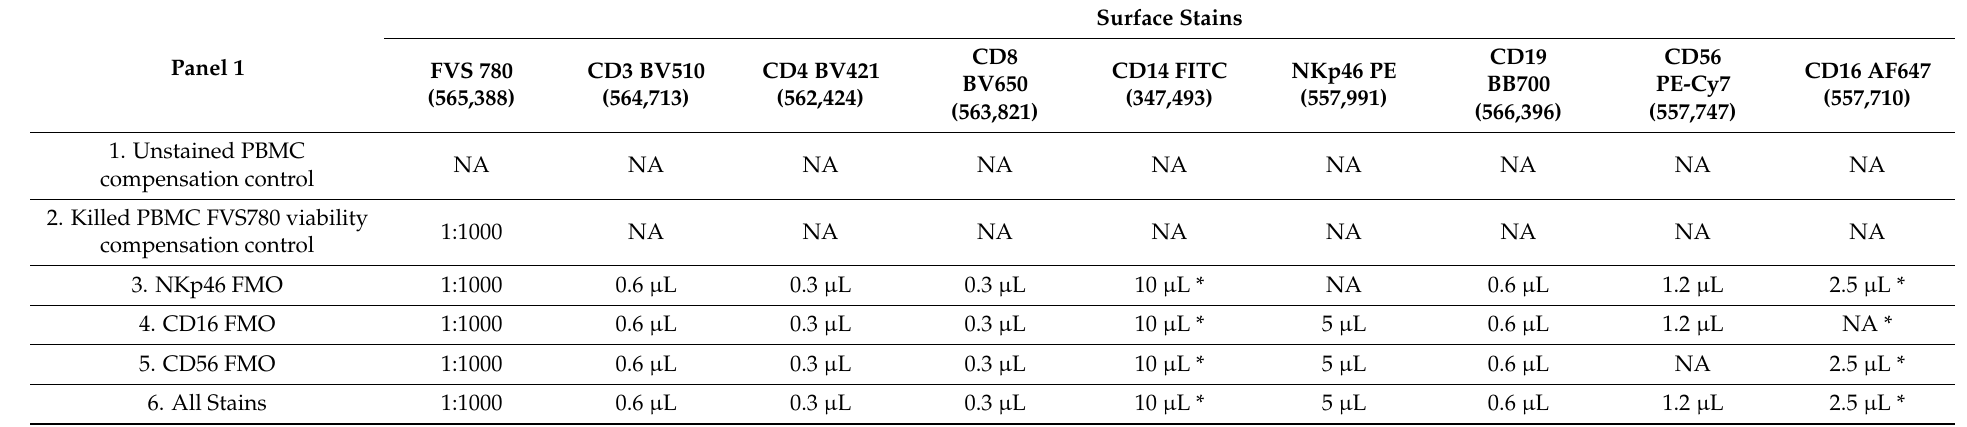
Table A2. Amount of Surface staining reagents for panel 1.